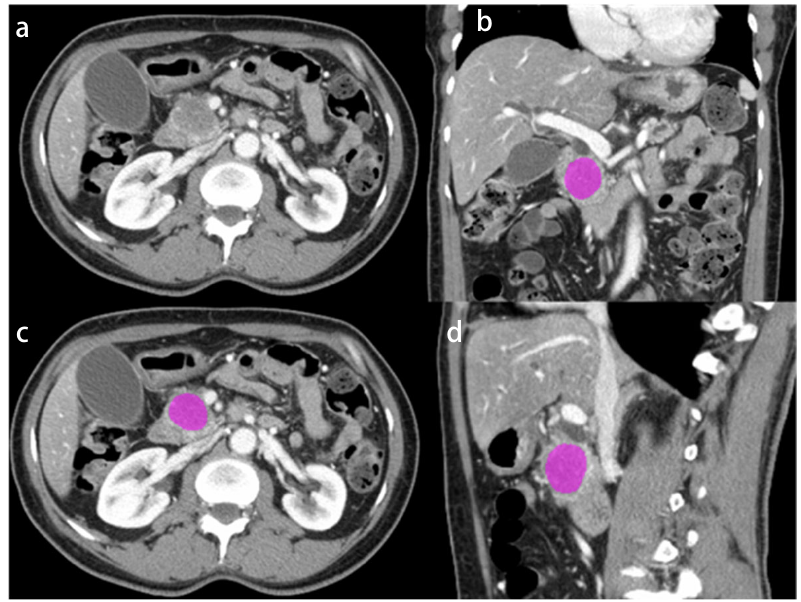
Figure 1. Axial CT image ( a ) and triplanar CT images with segmentation (displayed in pink; b , c , d ) in a representative 62 ‐ year ‐ old woman with PDAC in the pancreatic head.